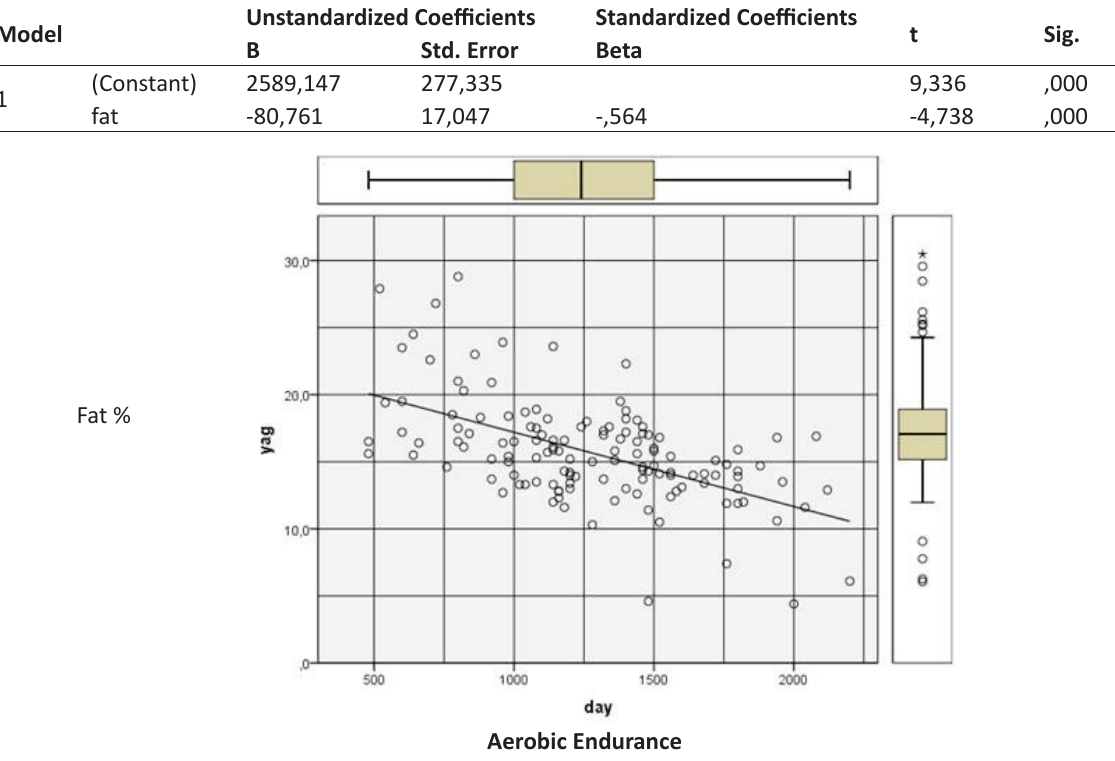
Figure 1. Relationship graph between aerobic endurance and